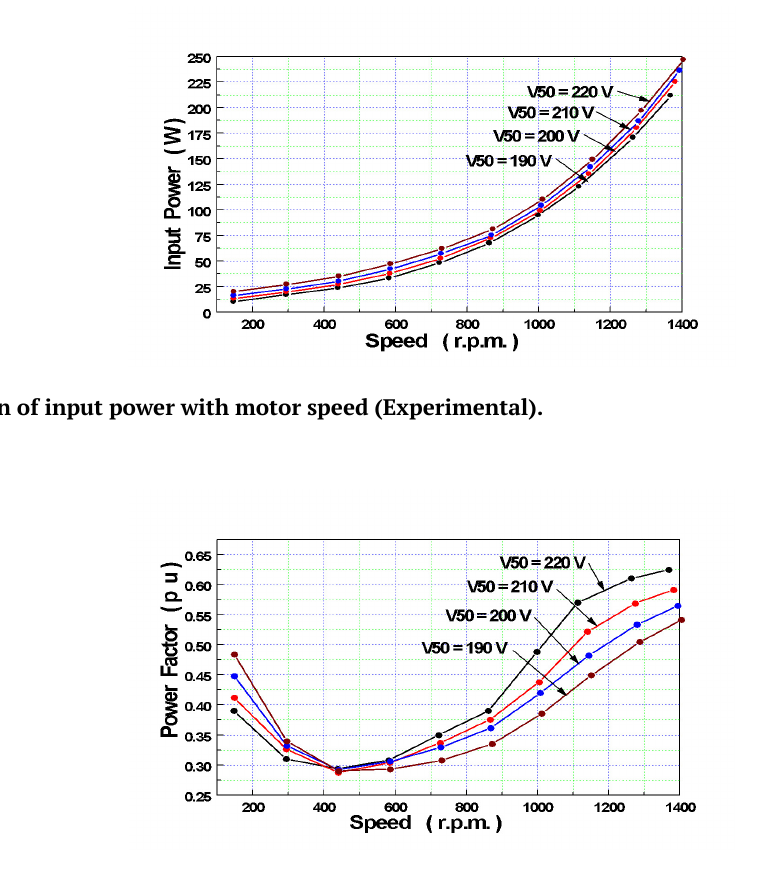
Fig. 14. Motor power factor variation with speed at different values of applied voltage